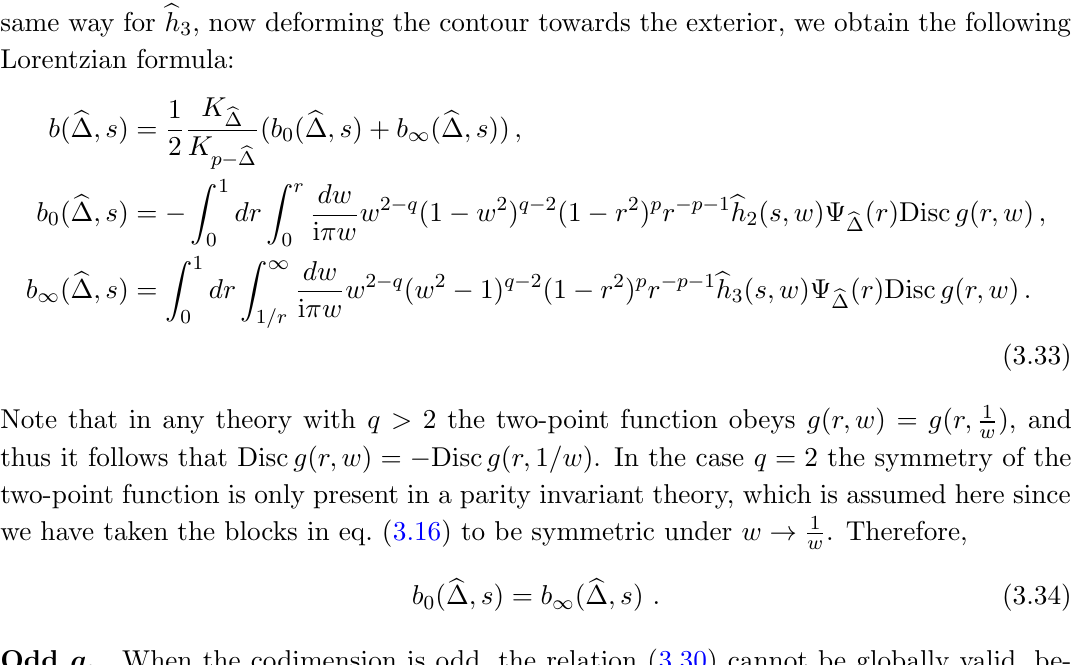
Figure 3 . Deformation of the in (3.33). For the case of odd codimension it was necessary to add zero in the form of two contours C + and C (cid:0)